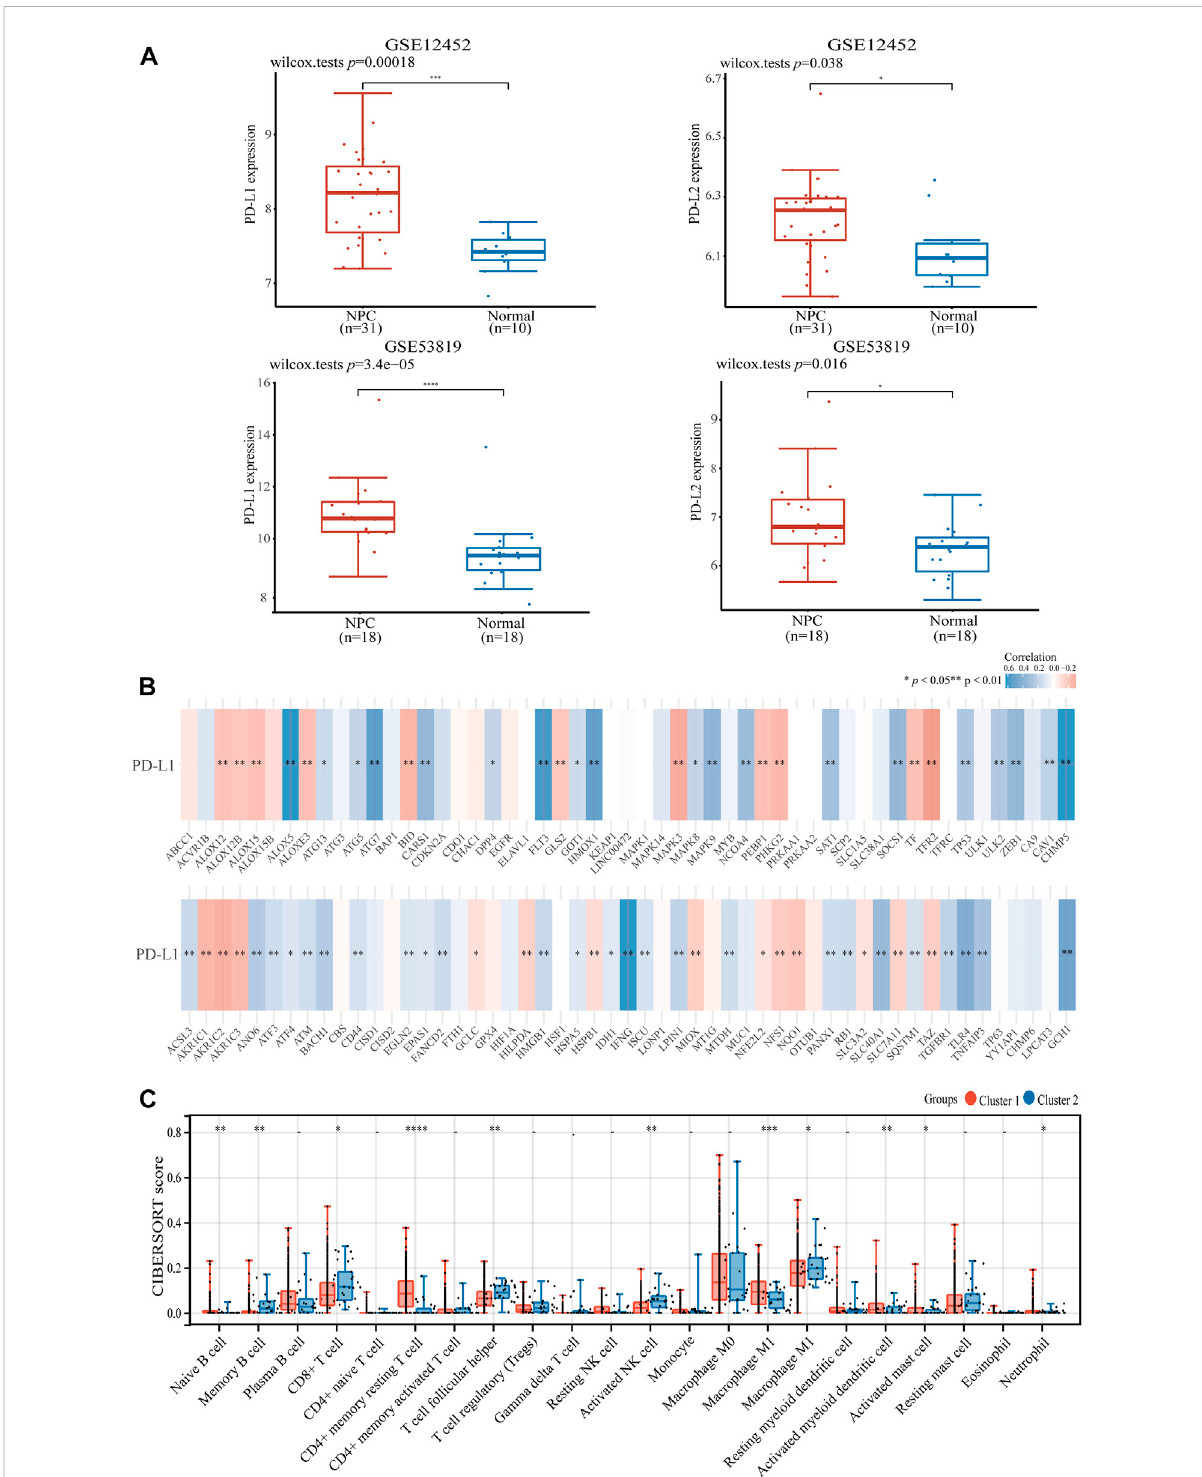
FIGURE 3 The expression of PD-L1 and PD-L2 in HNSCC and NPC patients. (A) The expression of PD-L1/PD-L2 in NPC and normal samples base on GSE12452 and GSE53819 dataset. (B) The correlation of PD-L1 with ferroptosis-related genes in TCGA HNSCC dataset. (C) The expression distribution of CIBERSORT immune score in two clusters of HNSCC samples. * p < 0.05, ** p < 0.01, *** p <